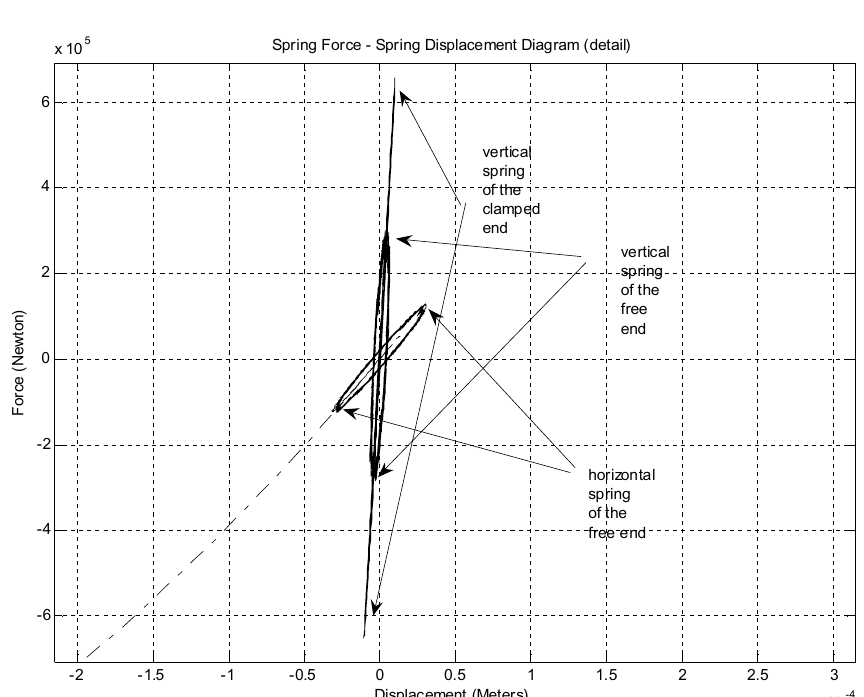
Fig. 9. Force-displacement diagrams of the hysteretic springs